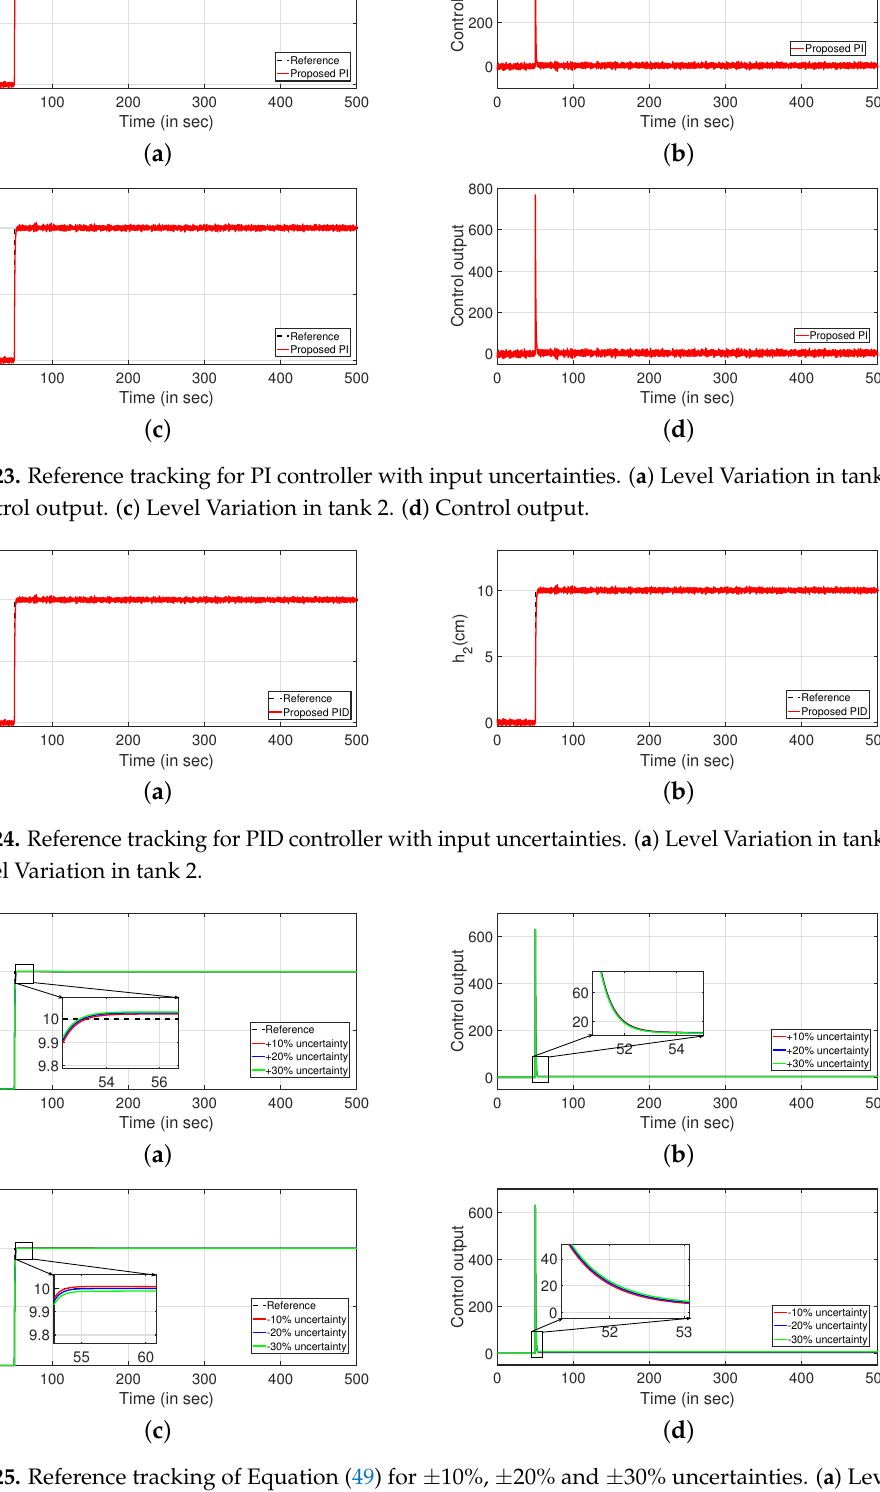
Figure 25. Reference tracking of Equation (49) for ± 10%, ± 20% and ± 30% uncertainties. ( a ) Level Variation in tank 1. ( b ) Control output. ( c ) Level Variation in tank 1. ( d ) Control